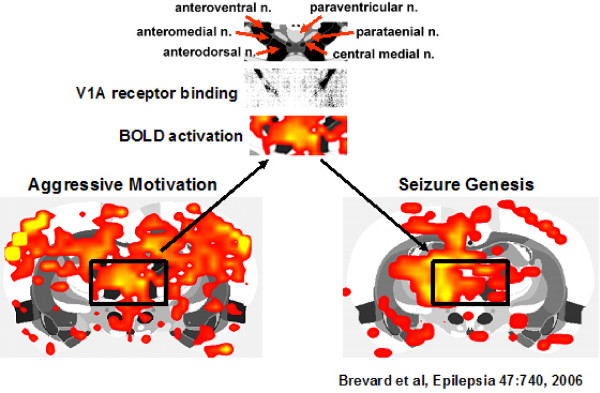
Anterior thalamic nuclei. Shown is a composite of figures depicting the anatomical details (top) of the dorsal midline thalamus at the level of the anterior thalamus, an autoradiograph (middle) of V1a binding density in the anterior thalamic nuclei (adapted from [100]) and BOLD activation (bottom) in the same thalamic area for aggressive motivation and seizure genesis (adapted from [67]).